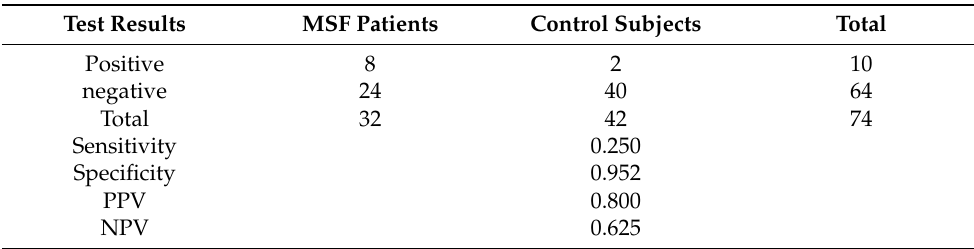
Table 5. Performances of a decision tree algorithm obtained using SNP typings from 292 random selected cases and controls for training and 74 for